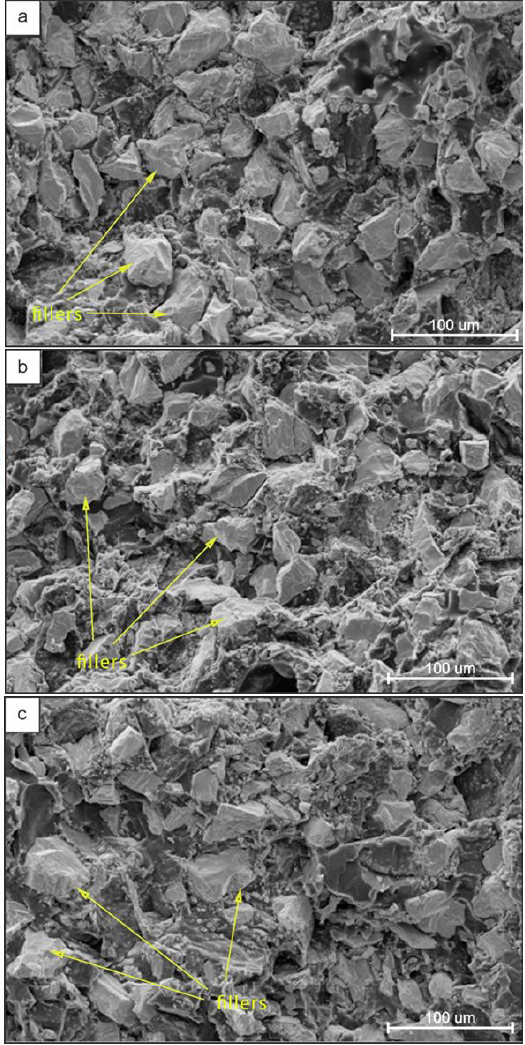
Figure 3. SEM micrographs of the (a) MC5, (b) MC7 and (c) MC10 samples.